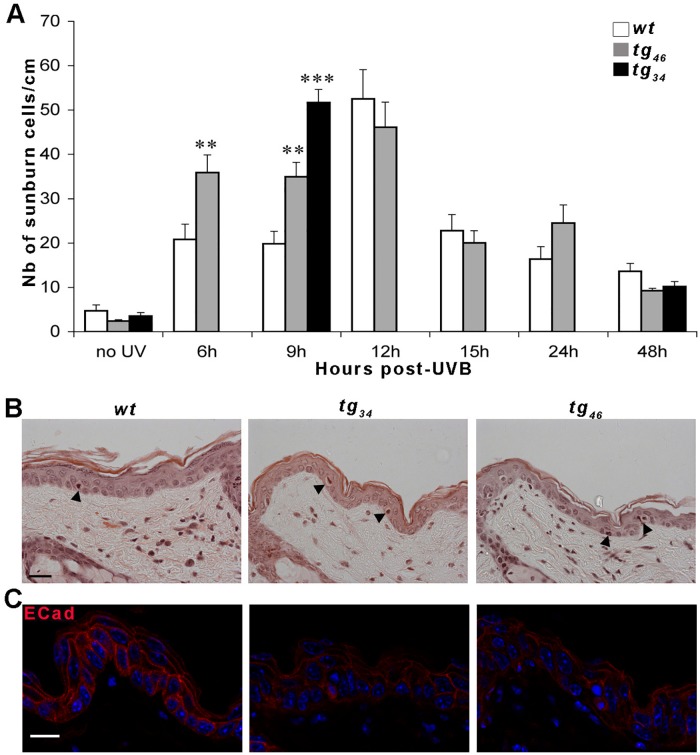
Aberrant epidermal response in transgenic mice after UVB irradiation.Mice were depilated on their back and irradiated with a single dose of UVB (2000J/m2). (A) Kinetic of apoptotic response. The number of sunburn cells per cm of epidermis was determined in unirradiated depilated skin (no UV) and in irradiated skin between 6h and 48h post-UVB exposure. A total of 61 mice were used for these experiments (Nwt = 25; Ntg
34 = 11; Ntg
46 = 25) i.e. 3 to 4 mice per genotype and per time point. Each bar represents the mean value ± sem. Statistical differences between wt and transgenic animals are noted **p<0.01 and ***p<0.001. (B) Histology. Representative hematoxylin-eosin sections of irradiated skin samples at 9h post-UVB. Apoptotic sunburn cells are indicated by black arrowheads. (C) Confocal analysis of E-Cadherin immunostaining on skin samples at 9h post-UVB. The signal is very weak and diffuse in tg
34 and tg
46 tissues compared to the wt. Three mice were used for each genotype. Scale bar: 20μm.